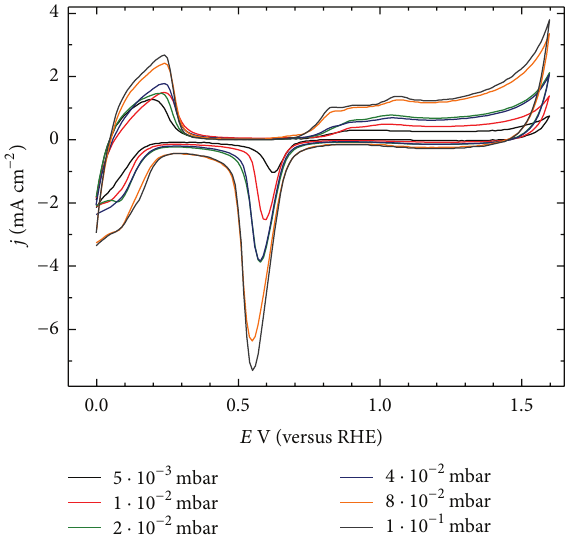
Figure 5: Cyclic voltammetry curves of the Pd layers deposited at varying sputtering pressures in 0.5 M H 2 SO 4 , potential scan rate 100mV ⋅ s −1 .